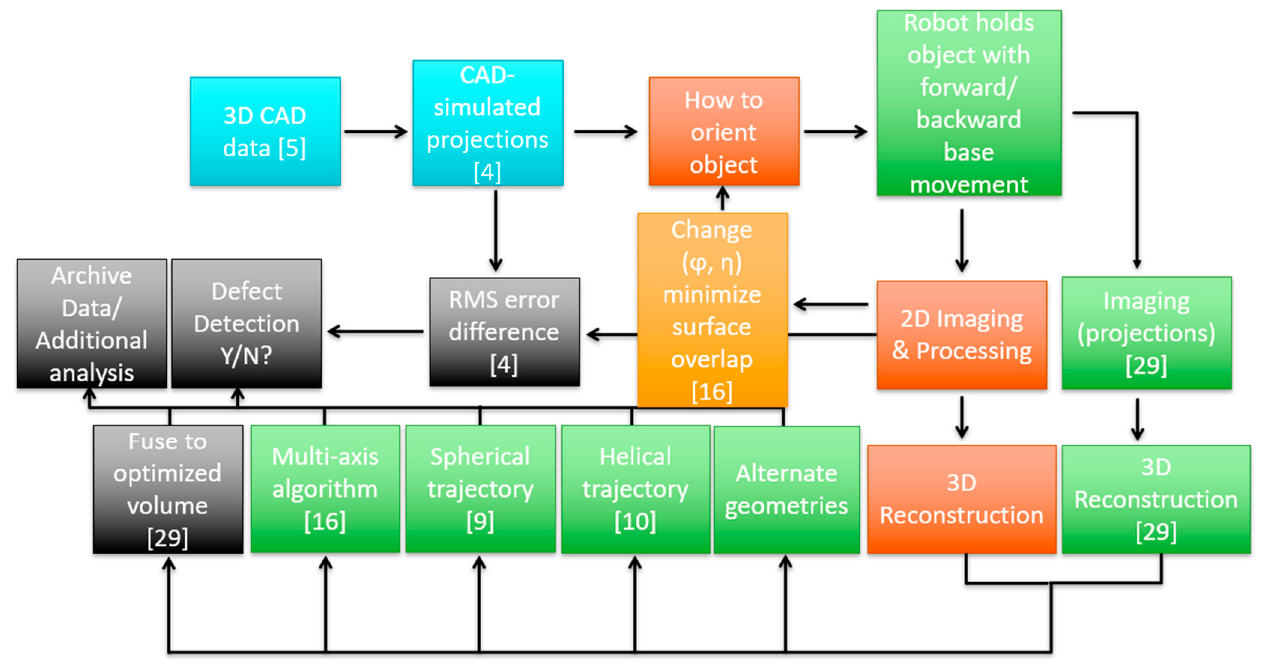
Figure 7. Computed tomography framework with the generic CT approach (dark orange), along with additional extensions for certain applications that can be applied. Box colors: prior inputted data (blue), feedback loop (light orange), generic CT approach modifications (green), and post-processing analysis (black). Reference numbers are included as an example for the papers that focus on each aspect or method.